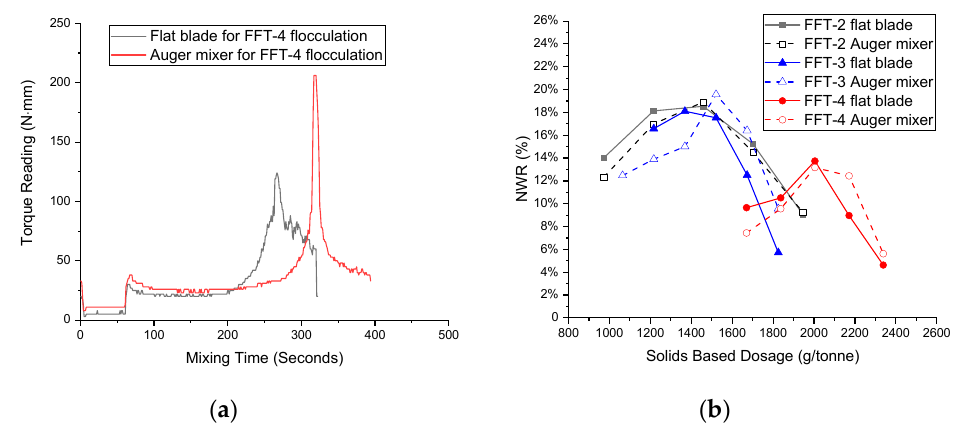
Figure 9. Geometries of mixing impellers: ( a ) flat mixer; ( b ) auger mixer.